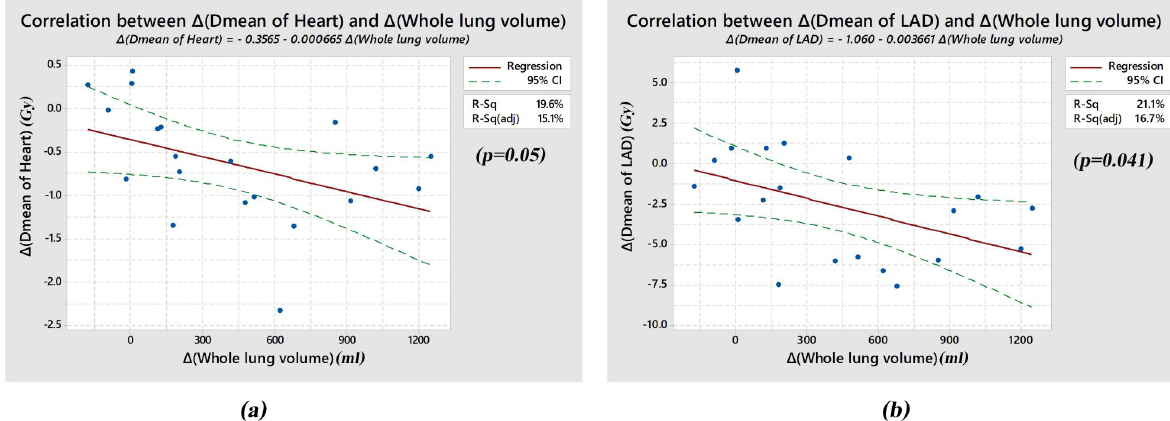
Fig 2. Correlation Between the Differences in Mean Heart Dose and Whole Lung Volume (a) and the Differences in Mean LAD Dose and Whole Lung Volume (b).